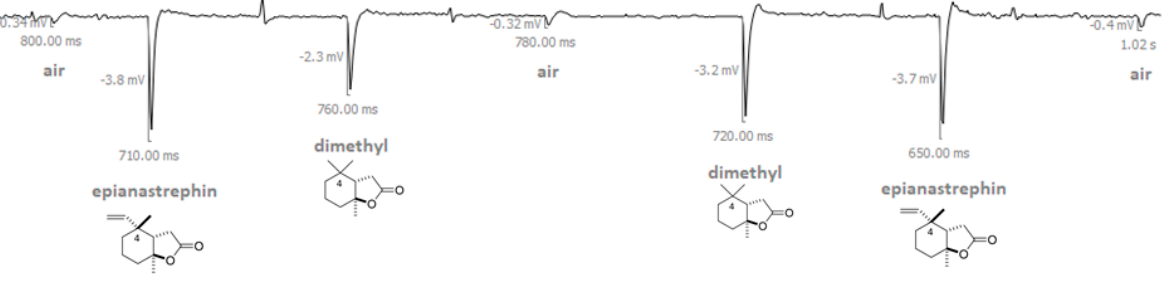
Figure 1. Example of electroantennographic output when an antenna of a sexually immature male of Anastrepha fraterculus was exposed to a series of air pulses (puffs) in this order: air, epianastrephin, ( ± )- trans -tetrahydroactinidiolide (dimethyl), air, ( ± )- trans -tetrahydroactinidiolide (dimethyl), epianastrephin, air (see Material and Methods section for more details). The amplitude of depolarization is displayed in millivolts (mV), and the time elapsed between the onset and the maximum of depolarization is displayed in milliseconds (ms) .